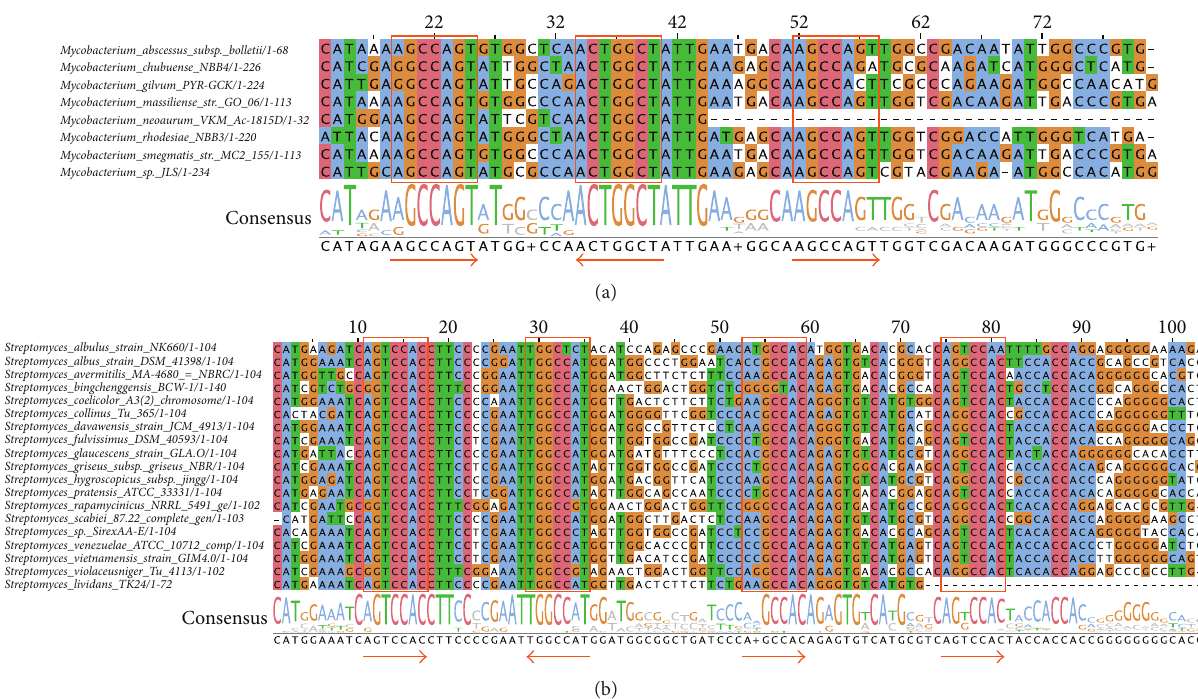
Figure9: Multiplealignments ofthepromoterregionsof theYczR regulons. Multiplealignmentsof thepromoter regionsoftheYczR